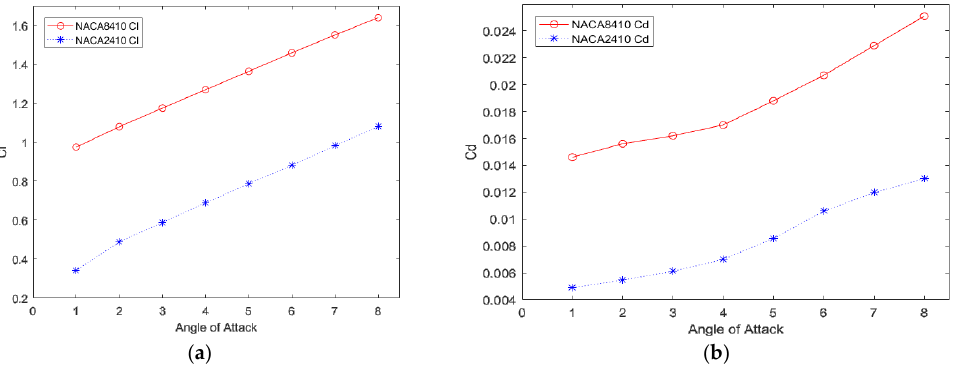
Figure 11. ( a ) of NACA2410 and NACA8410 vs. varying AoA. Figure 11. C D ( b ) and C L ( a ) of NACA2410 and NACA8410 vs. varying